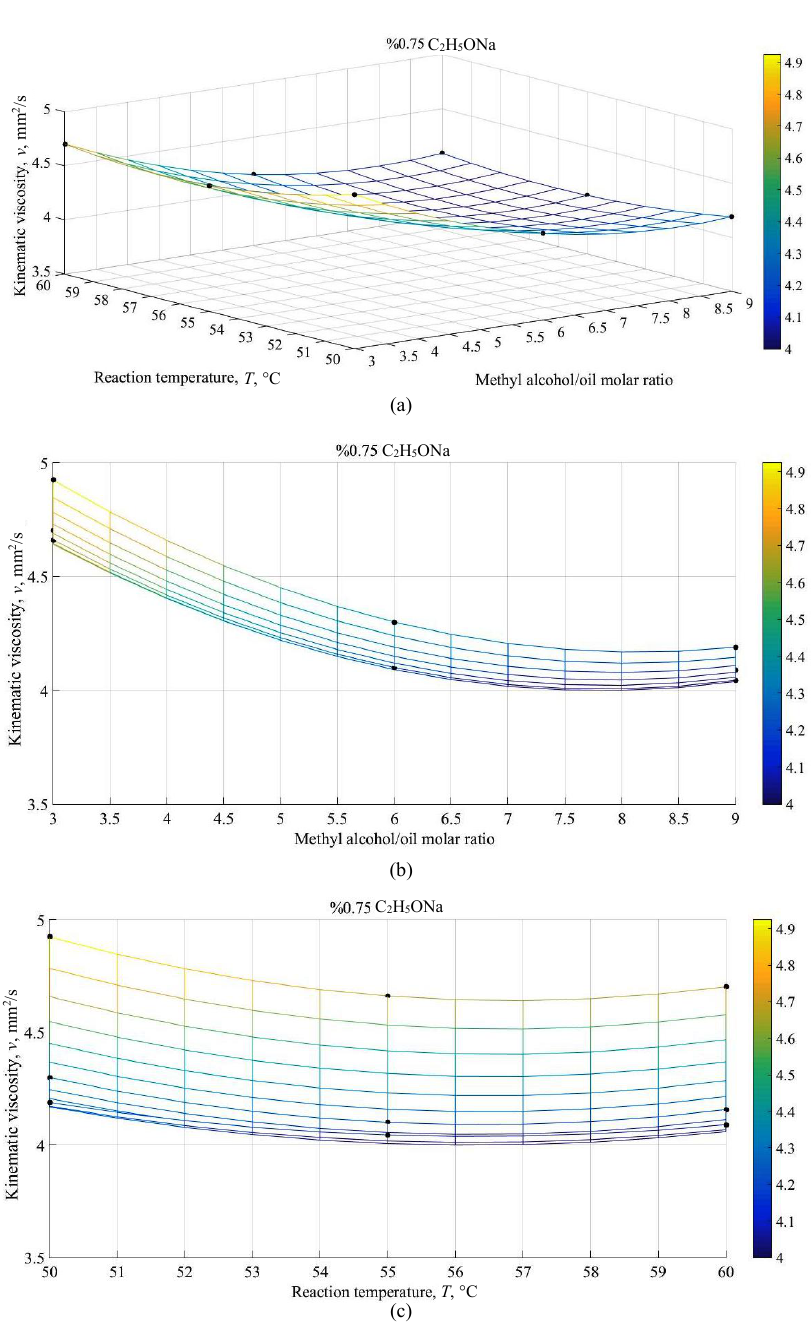
Fig. 1. Change of methyl ester viscosity (a) vs. reaction temperature and alcohol/oil molar ratio simultaneously; (b) alcohol/oil molar ratio; (c) reaction temperature for the catalyst concentration of 0.75